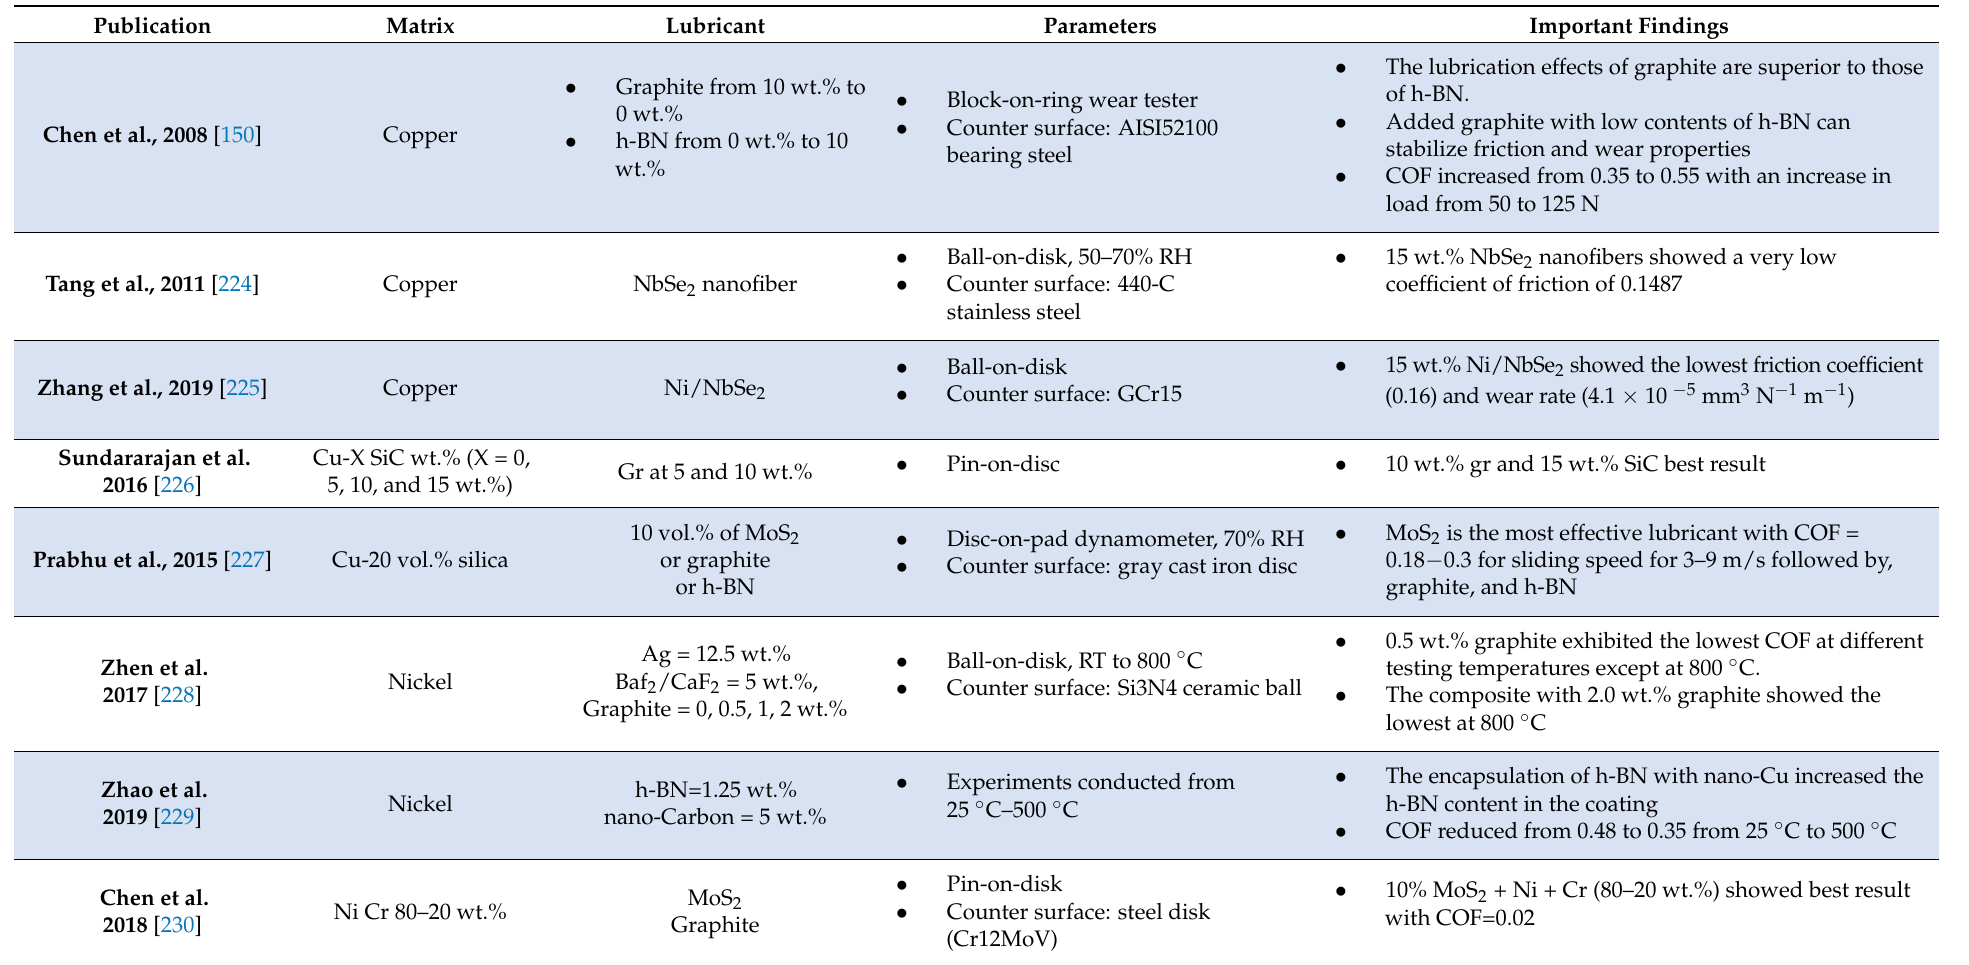
Table 4. Some publications on using matrix composites for solid lubrication from 2000 to